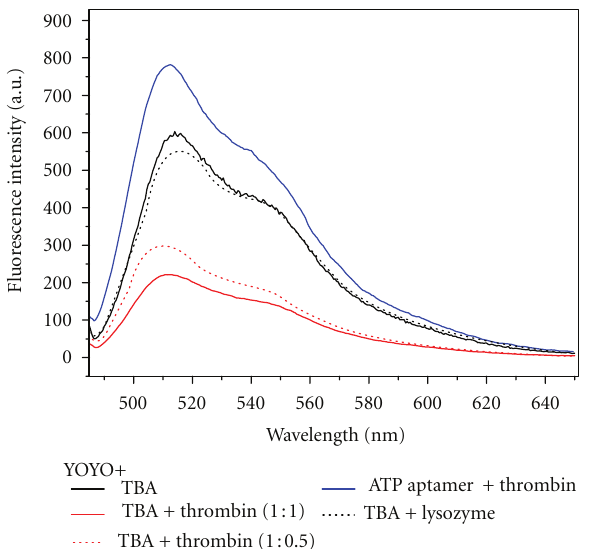
Figure 3: Comparison of fluorescence emission spectrum of YOYO in presence of TBA, TBA + thrombin (in two ratios), ATP aptamer and TBA + lysozyme. Samples contain 25 nM of YOYO and 10 nM of aptamers. Amount of thrombin used was 10nM and 5nM corresponding to 1: 1 and 1 :0.5 with respect to TBA.